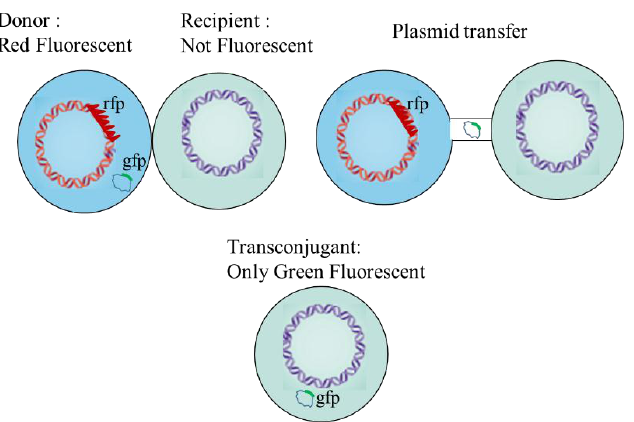
Figure 1. Schematic representation of gene transfer with tagged bacteria system: Donor cells show red fluorescence; recipient cells were no fluorescence expression; and the transconjugants show green fluorescence after gene transfer.